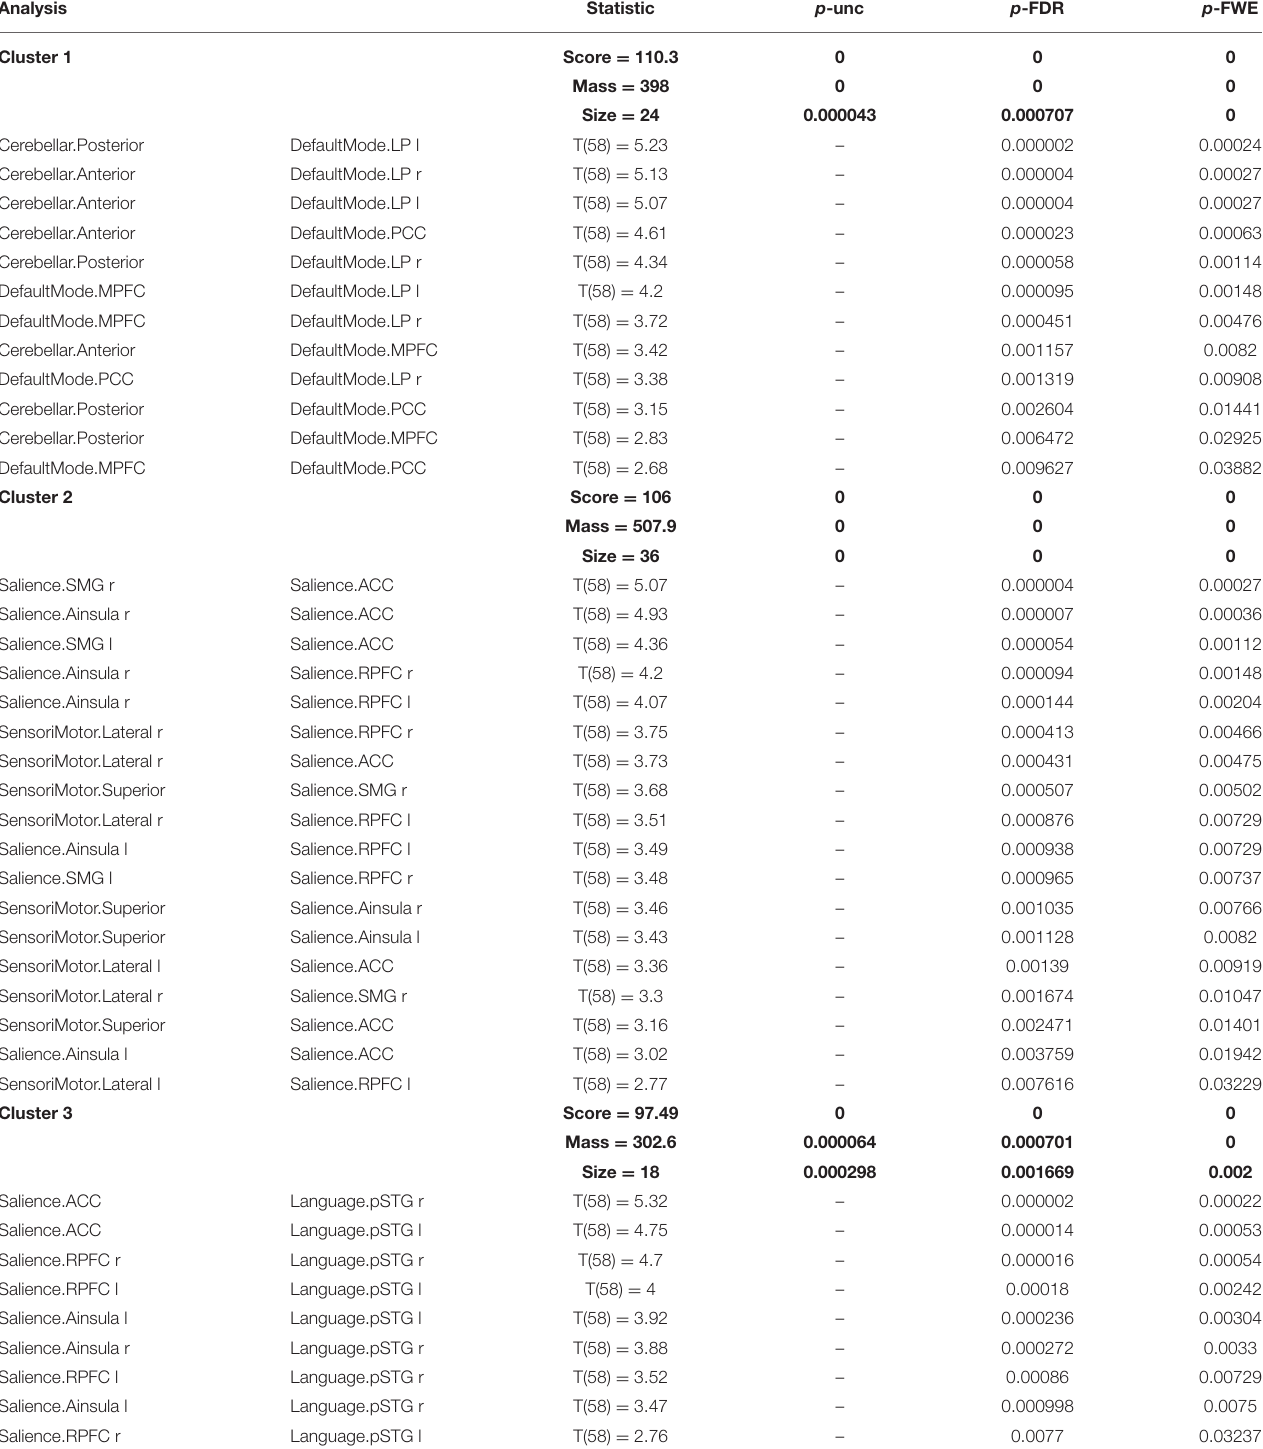
TABLE 2 | Statistical cluster analysis of the networks using spatial pairwise clustering (SPC) presenting increased connectivity between